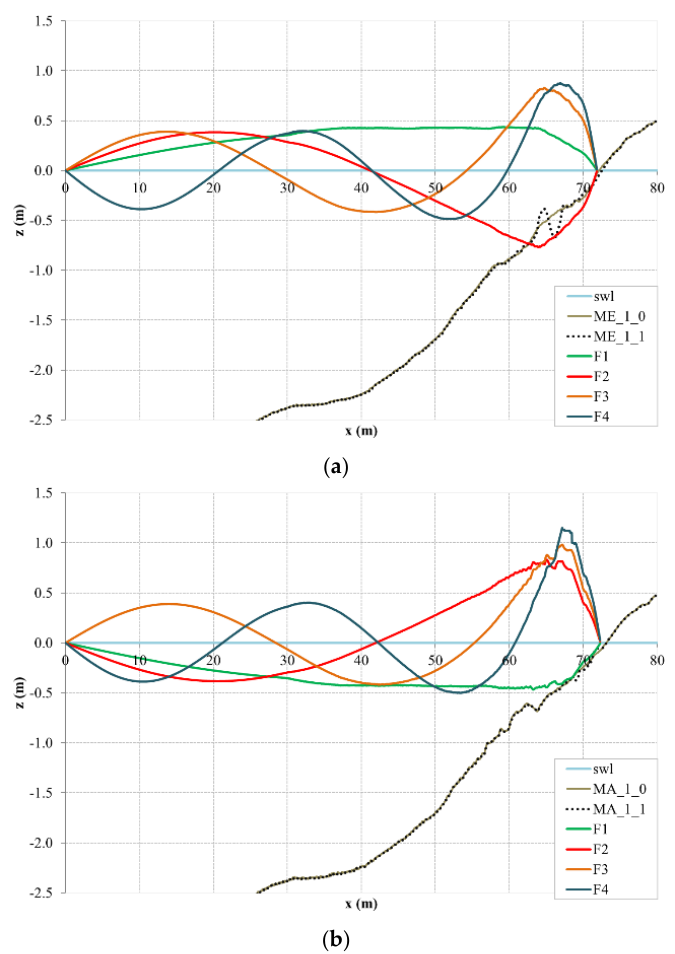
Figure 8. Eigenmodes for volume flux q related to the profile measured in monochromatic tests: ( a ) ME and ( b ) MA.